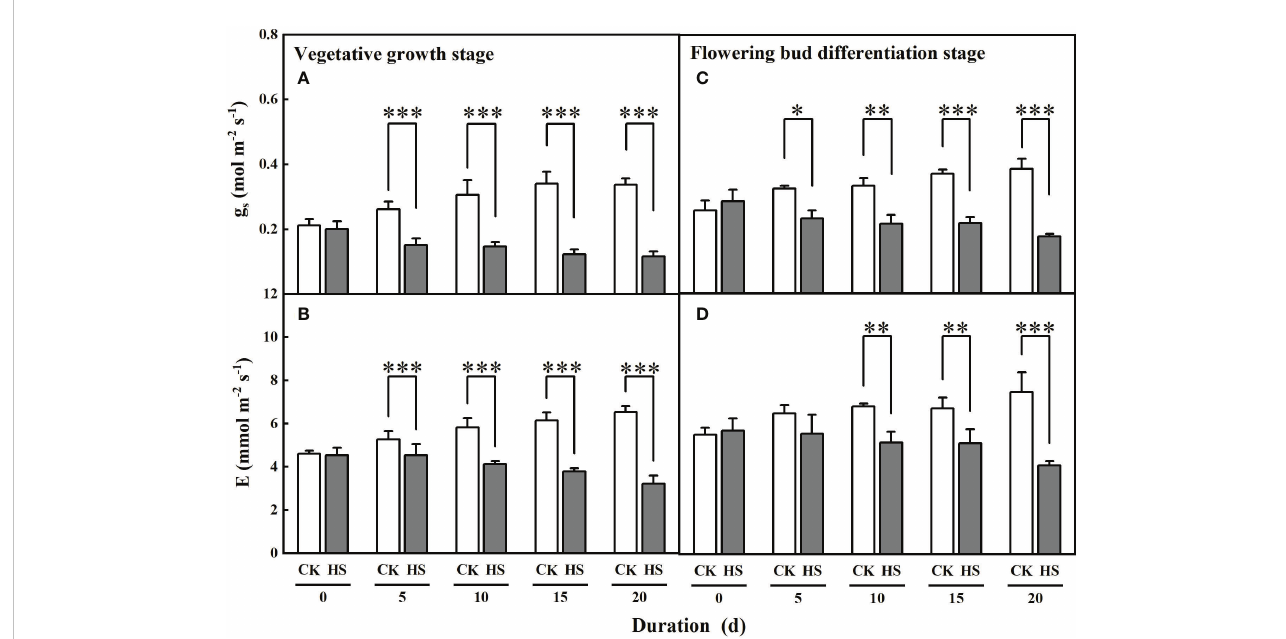
FIGURE 5 Effects of heat stress (HS) during the vegetative growth (A, B) and fl owering bud differentiation stages (C, D) on leaf stomatal conductance (g s ; A, C ) and leaf transpiration ( E; B, D ) of gerbera. CK is the control treatment. Values are the mean ± SD (n = 3). *, **, and *** represent the signi fi cant level at P <0.05, P <0.01, and P <0.001,